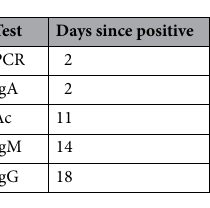
Table 1. Correction factor (days) by kind of test, since a patient may be infected by the virus until a test can detect in general terms that the patient is